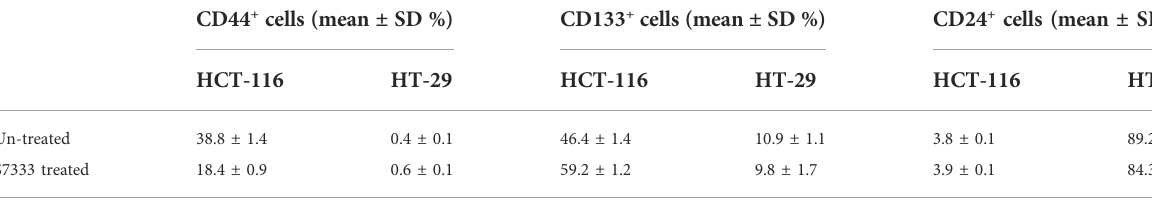
TABLE 1 Comparison of the positive rate of cancer stem surface makers between HCT-116 and HT-29 cells before and after S7333 treatment.